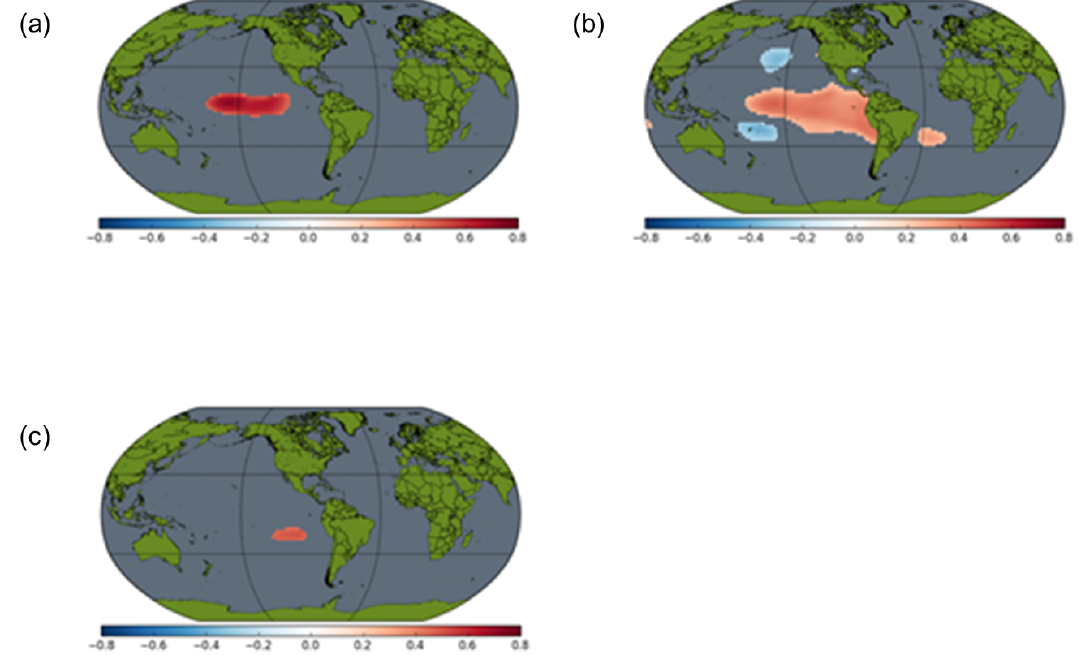
Figure 7. May–August global multivariate ENSO index (MEI) correlated with October–January streamflow at Algarrobal for (a) positive MEI years, (b) all MEI years, and (c) negative MEI